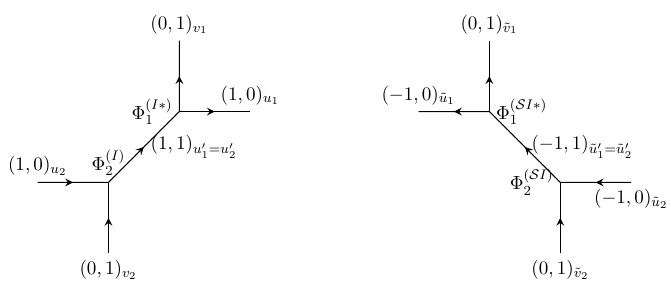
Figure 3 . Representation of the Lax matrix L ( I ) and L ( S I )